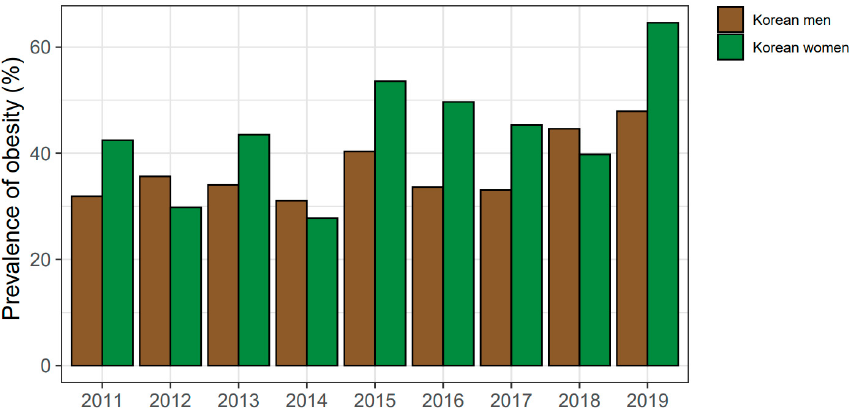
Figure 2. Sex-specific prevalence of abdominal obesity in stroke subjects according to 2011–2019 KNHANES datasets. Prevalence of abdominal obesity (waist circumference ≥ 90 cm for men and ≥ 85 cm for women) was calculated by weighted men and women diagnosed with stroke. Abbreviation: KNHANES, Korea National Health and Nutrition Examination Survey.